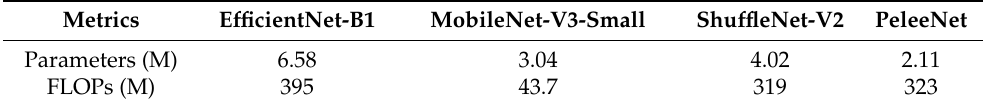
Table 1. Complexity of the compared